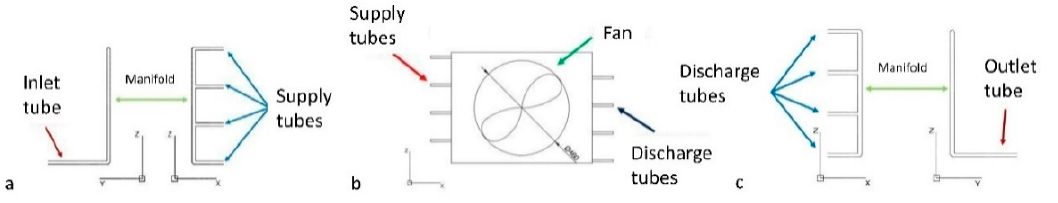
Figure 4. Schematic structure of the second level of the numerical model: ( a ) upstream structure composed by the manifold and four supply tubes; ( b ) core structure composed by the inlet supply tubes, the heat exchanger and the outlet discharge tubes; ( c ) downstream structure composed by the four discharge tubes and the manifold. The refrigerant flows inside the tubes along the x-direction. The air flows through the heat exchanger along the y-direction. The supply tubes are arranged along the z-direction.